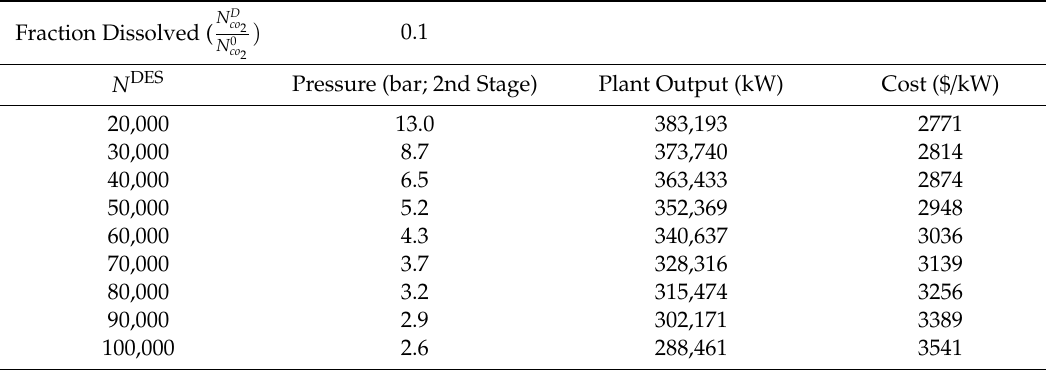
Table 3. Dual-Stage Model output for METPB:EG system at 10%, 20%, and 30% CO 2